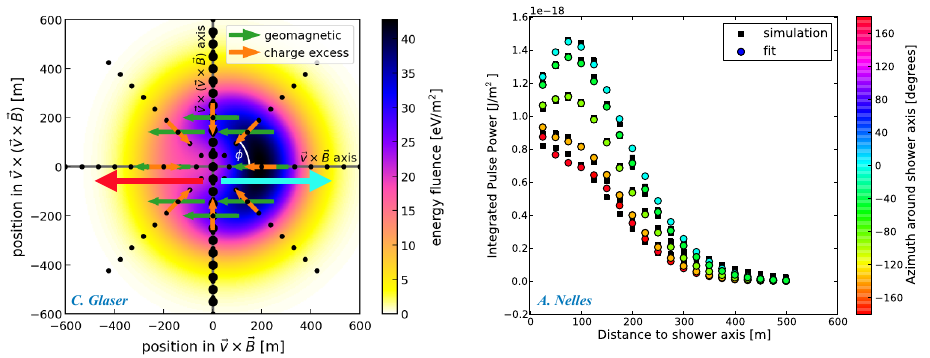
Figure 1: (left) Distance to X max as a function of the zenith angle for an average X max of 669g / cm 2 for Figure 1. Left: Distribution of the energy fluence (in the 30 − 80 MHz band) of an air shower with two observation altitudes. The dotted line shows the distance to X max where the air shower has emitted 60 ◦ zenith angle [5]. Superimposed is the polarization direction of the geomagnetic and charge-excess all its radiation energy. (right) Distribution of the energy fluence (in the 30-80MHz band) of an air shower emission processes at di ff erent positions in form of arrows. Simulated with CORSIKA / CoREAS [6, 7]. with 60  zenith angle at an observation altitude of 1564m a.s.l., which corresponds to the height of the Right: Lateral distribution of the radiation power on the ground for bins in azimuthal angle, following Engineering Radio Array of the Pierre Auger Observatory. Superimposed is the polarization direction of the a parameterization described in geomagnetic and charge-excess emission processes at di↵erent positions in form of arrows.